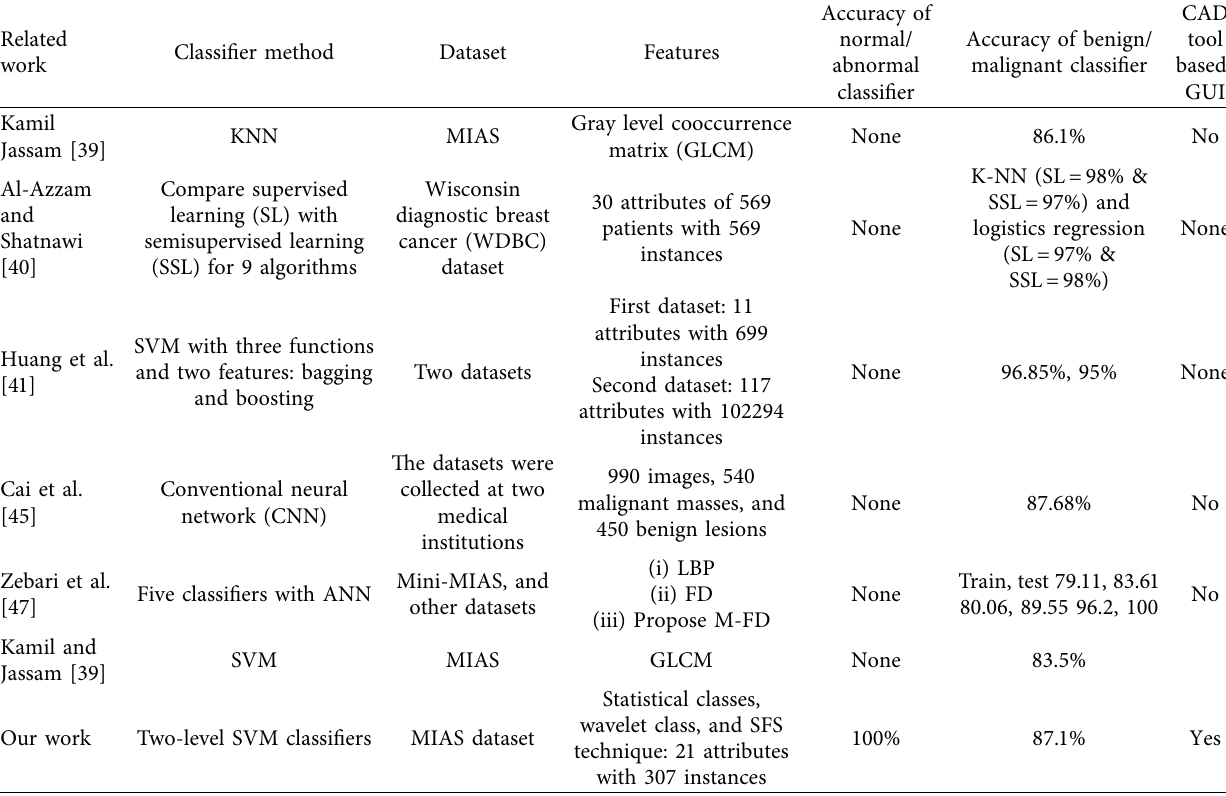
Table 7: The comparative study with related